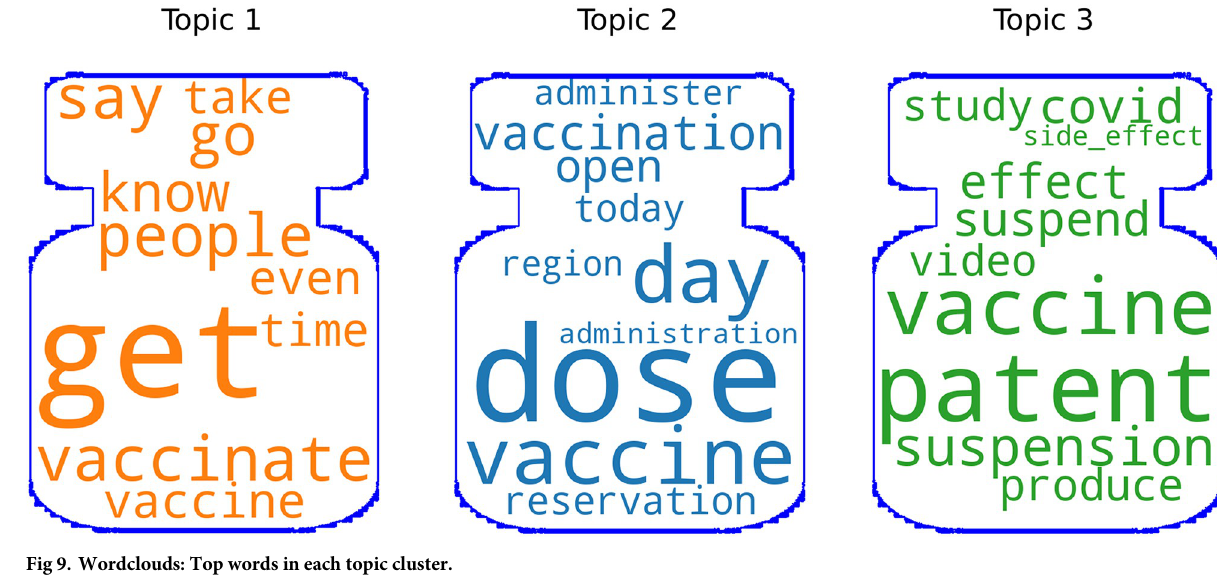
Fig 9. Wordclouds: Top words in each topic cluster.